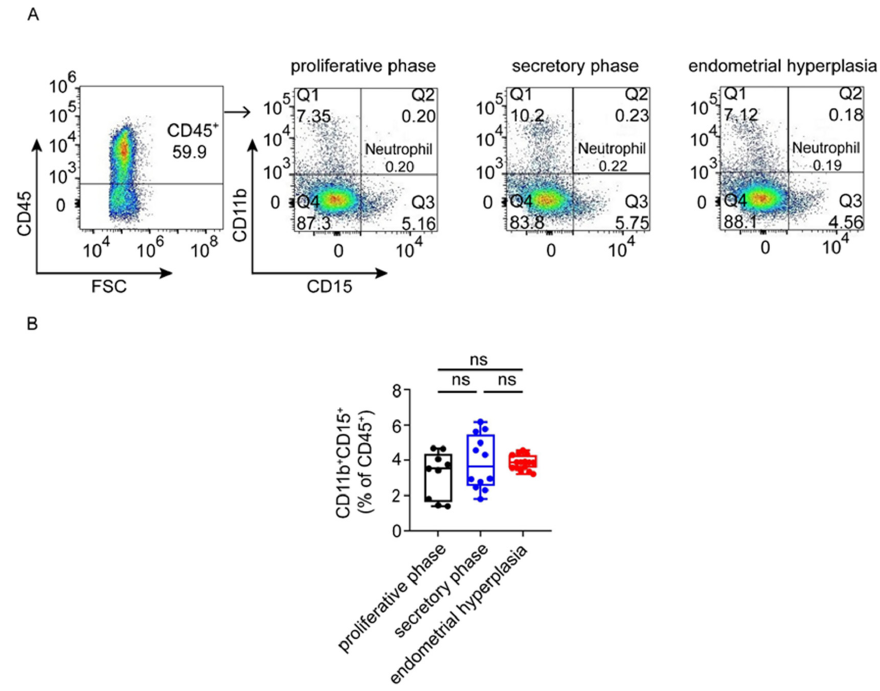
Figure 2. The proportion of neutrophils in proliferative phase, secretory phase and endometrial hyperplasia endometrium of AUB patients. ( A , B ) Gating strategy was used to distinguish neutrophils. CD45 + gate was first used to gate cells, followed by CD11b and CD15 gates. Graph shows the proportion of total CD45 + CD11b + CD15 + neutrophils in proliferative phase, secretory phase and endometrial hyperplasia groups. Data are presented as the median and the interquartile range. Statistical significance (Kruskal–Wallis test with Dunn’s multiple-comparison test): ns, no significant difference.